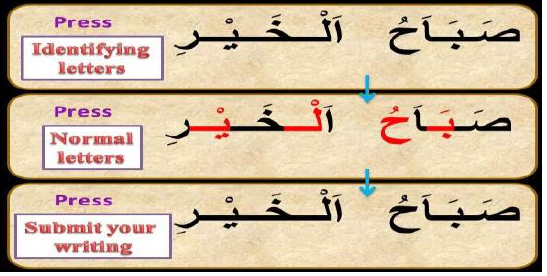
Figure 10. Identifying Arabic letters